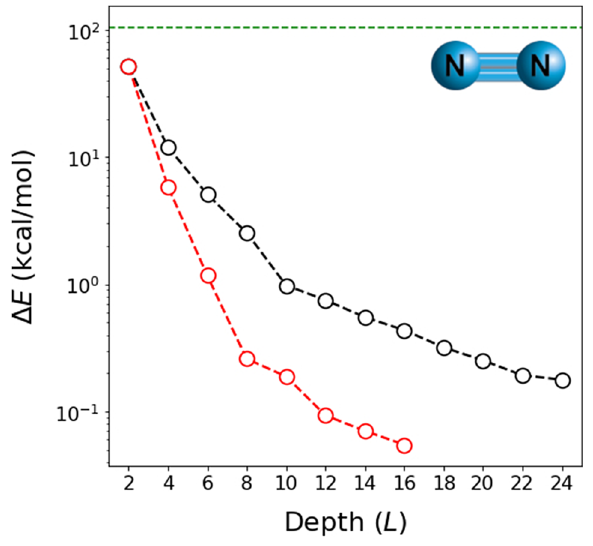
FIG. 10. Energy error (cid:7) E = E VQE − E exact versus 2D hardware-efficient ansatz depth L for the 16-qubit N 2 in the STO-3G basis based on default (black) and permuted qubit Hamiltonians (red) built from approximate wave functions. The results are based on a noiseless